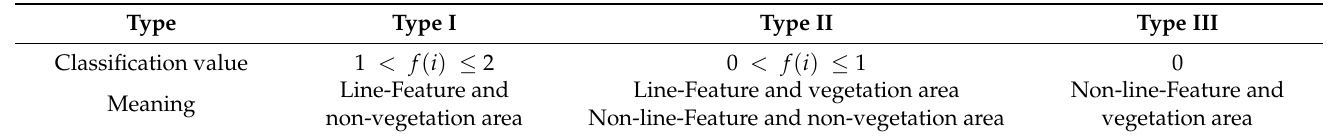
Table 1. Classification of feature points.